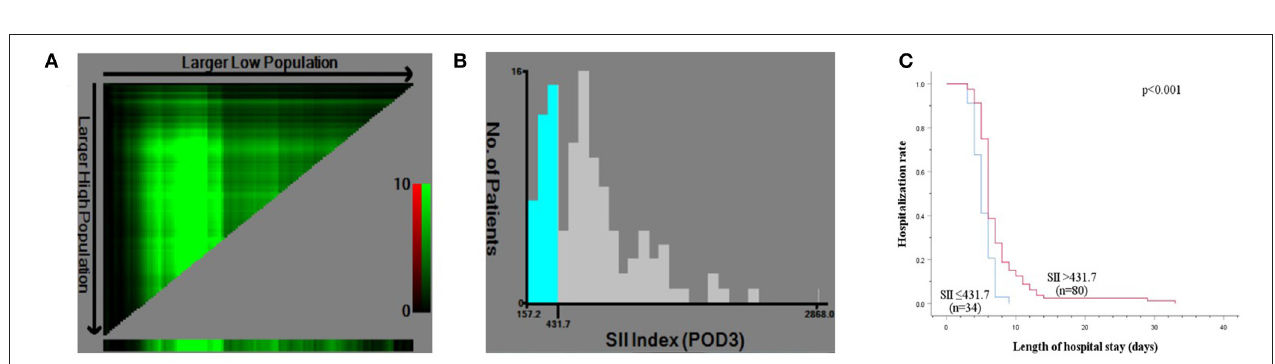
FIGURE 2 | Changes in the level of (A) SII, (B) NLR, (C) PLR, and (D) MLR on preoperative day, postoperative day (POD) 1 and POD 3. Values are presented as mean ± standard deviation. SII, systemic immune–inflammation index; NLR, neutrophil-to-lymphocyte ratio; PLR, platelets-to-lymphocyte ratio; MLR, monocyte-to-lymphocyte ratio.